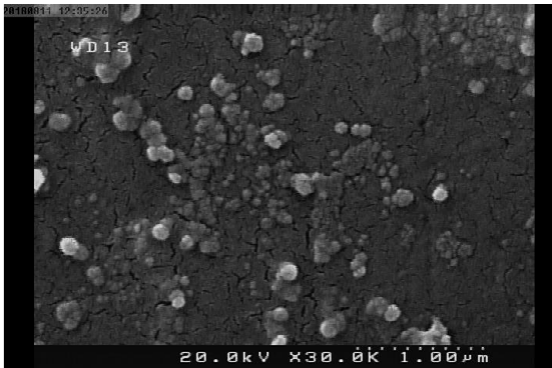
Fig. 2: FESEM image of exosomes isolated from U87 cell line